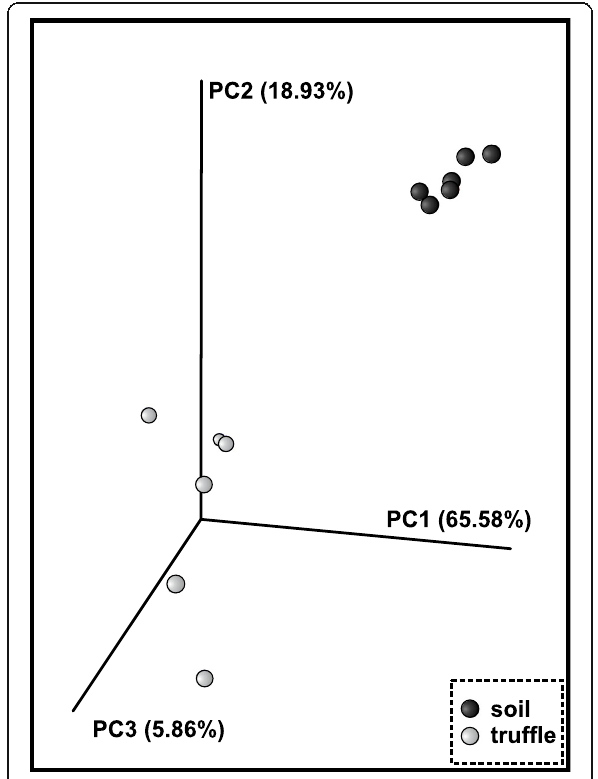
Fig. 2 Principal Coordinate Analysis (PCoA). Plot was generated using weighted UniFrac distance matrix. Soil (black spheres) and truffle (gray spheres) samples are